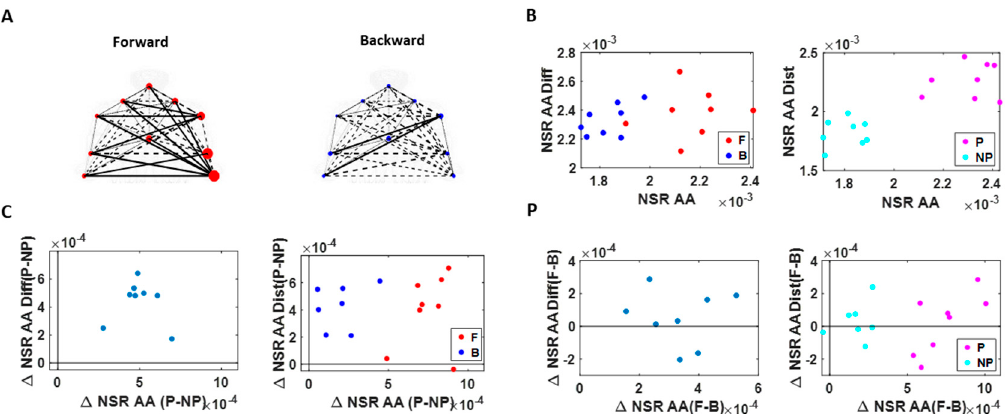
Figure 6. NSR signatures during pointing can di ff erentiate the levels of intent. Comparison includes forward–deliberate vs. backward–spontaneous segments and performing vs. non-performing e ff ector. ( A ) Network visualization of a right-handed representative participant. Node size is represented by the NSR derived from the corresponding body part’s kinematics time series, and edge thickness is represented by the NSR of the absolute di ff erence in kinematics between the corresponding pairs of body parts. Node size and edge thickness are graphed in the same scale across di ff erent movement segments (i.e., forward and backward segments). ( B ) NSR for di ff erent movement segment and sides. Each dot is the median NSR values for each participant’s di ff erent movement segments (left) and di ff erent sides (right) from the unitless MMS derived from the angular acceleration (AA) fluctuations in amplitude. The x-axis denotes the NSR from individual body part’s kinematics (NSR AA), and y-axis denotes the NSR from the MMS derived from the absolute pairwise body parts’ di ff erence (NSR AA Di ff ). Generally, for the former (NSR AA) measure, NSR is higher during a forward segment (F;